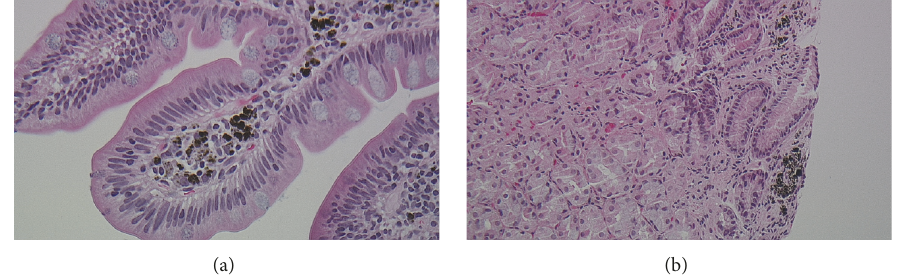
Figure 2: Hematoxylin and eosin stain ( × 400) of the gastric (a) and small intestinal mucosa (b) showing dark brown clumpy pigment present within histiocytes in lamina propria.